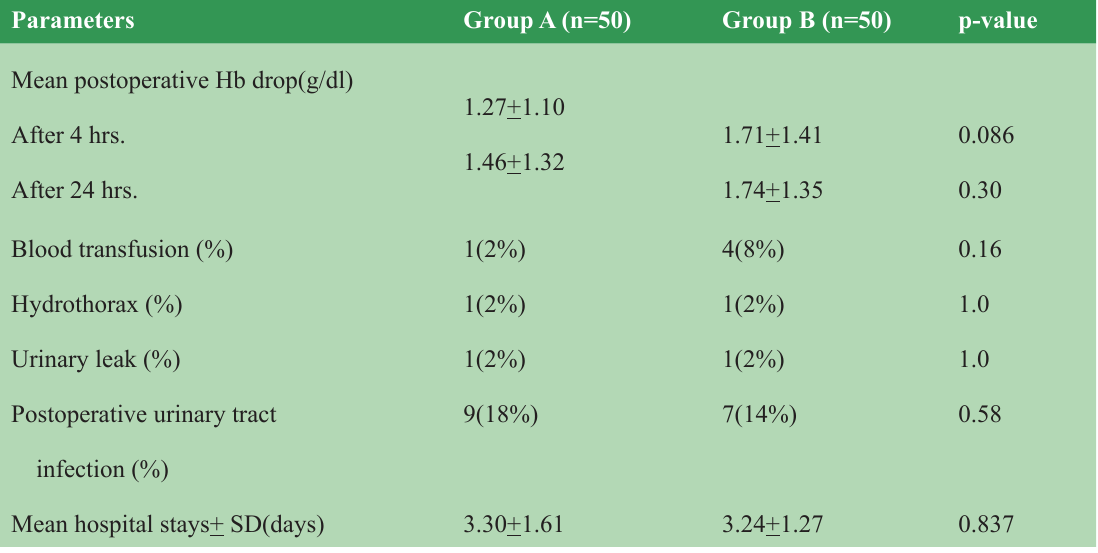
Table 3. Postoperative values and outcome of procedure